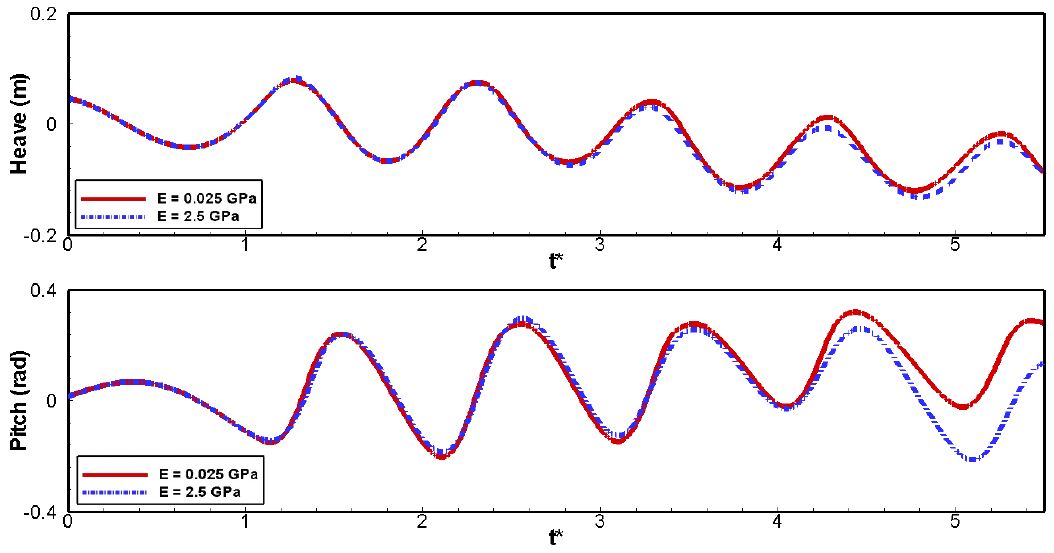
Figure 10. Heavy and pitch of the plate with Young modulus E = 2.5 GPa under severe wave conditions with wave steepness ka = 0.5. Ratio of the plate length to the wavelength is 2 L / λ = 0.43 .